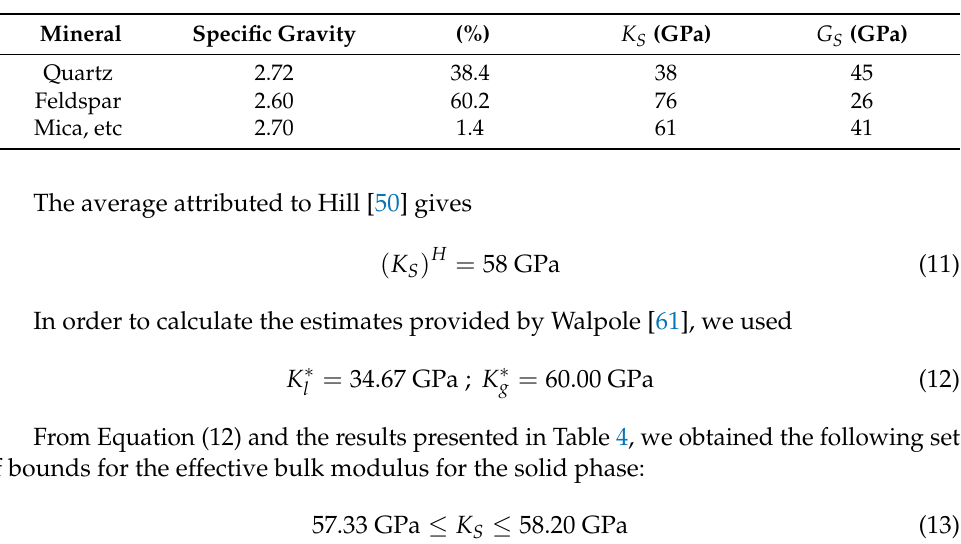
Table 4. The MIAM Mineralogical composition and K S and G s values for the solid phases of the Lac du Bonnet